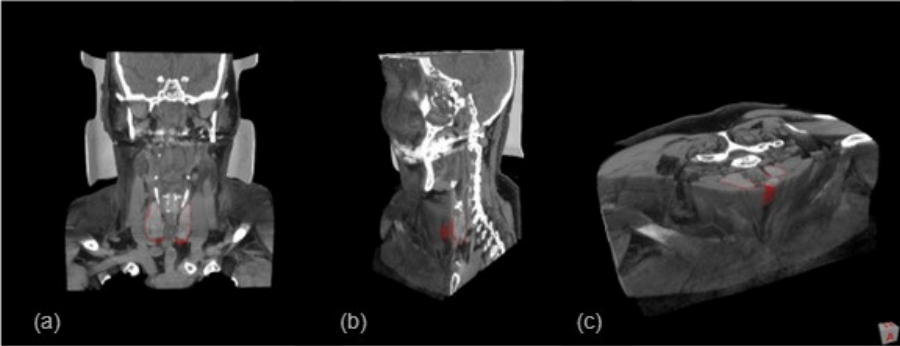
Figure 18. Anatomy images (DICOM) showing the corresponding 3D visualization in MeVisLab. Special attention is given to the detail of the segmented thyroid region (represented in red), within the three views: ( a ) coronal, ( b ) sagittal and ( c ) axial.